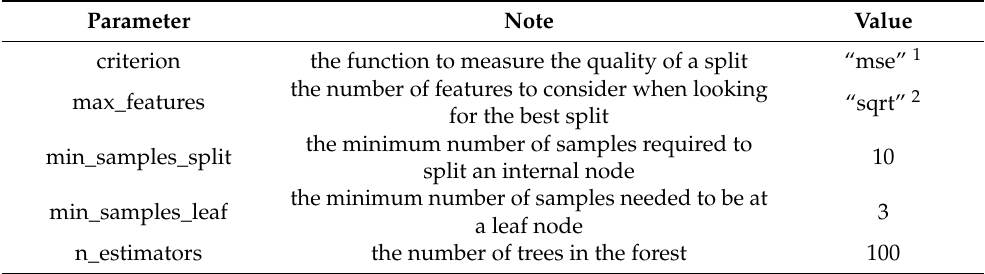
Table 6. Parameter settings for